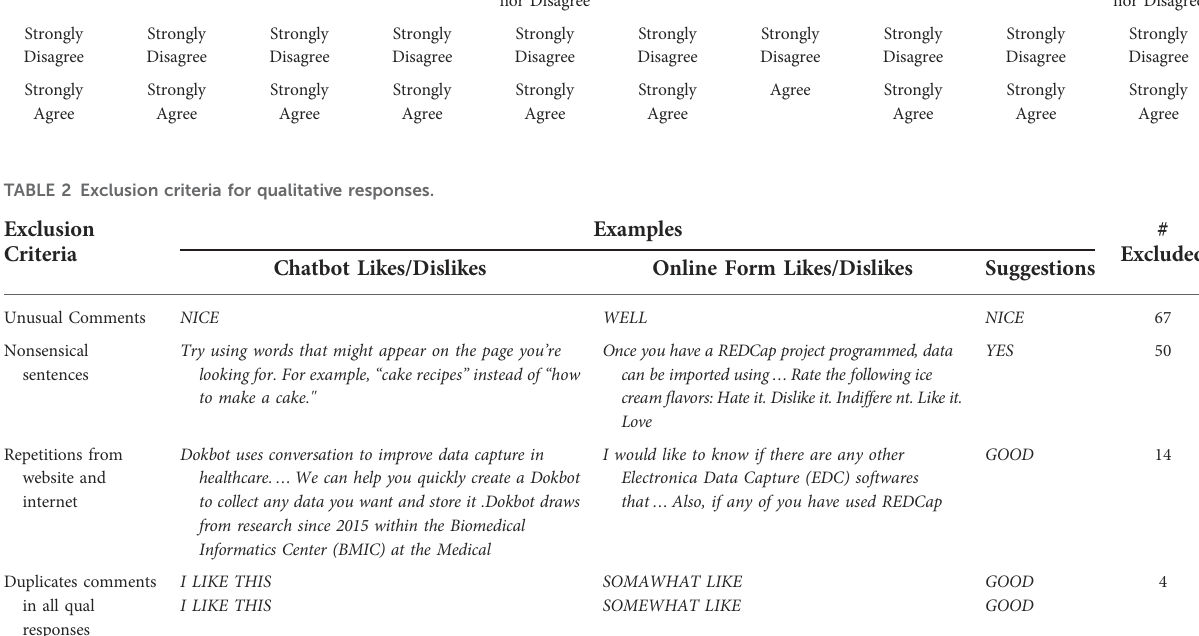
TABLE 1 Examples of participant responses for system usability scale with ≥ 8 same responses.